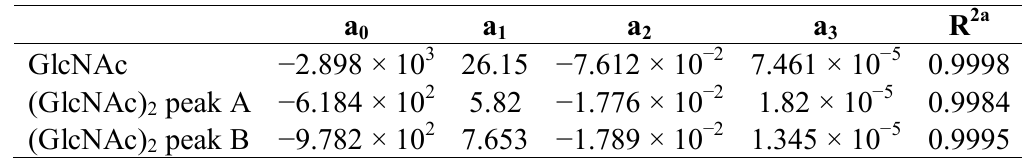
+ a T + a T 2 + a T 3 0 1 2 3